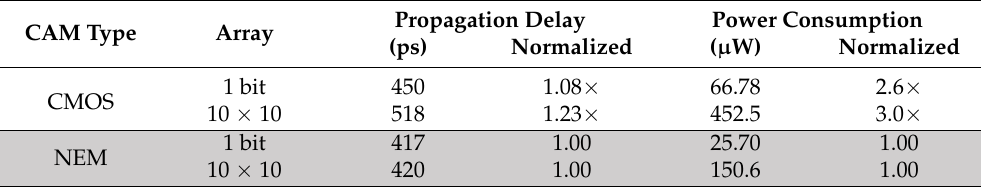
Table 2. Comparison of propagation delay and power of CMOS-based CAM and NEM-based CAM. CAM